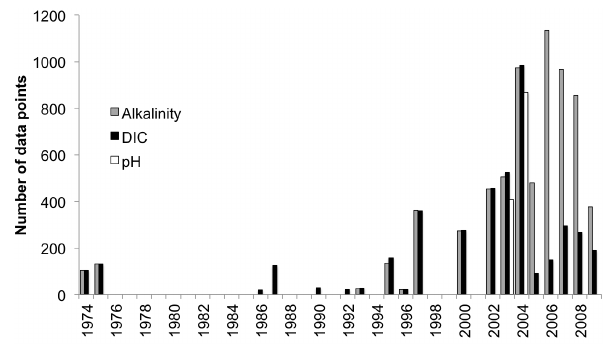
Figure 4. Distribution of alkalinity, DIC and pH data points in- cluded in the data set by year.